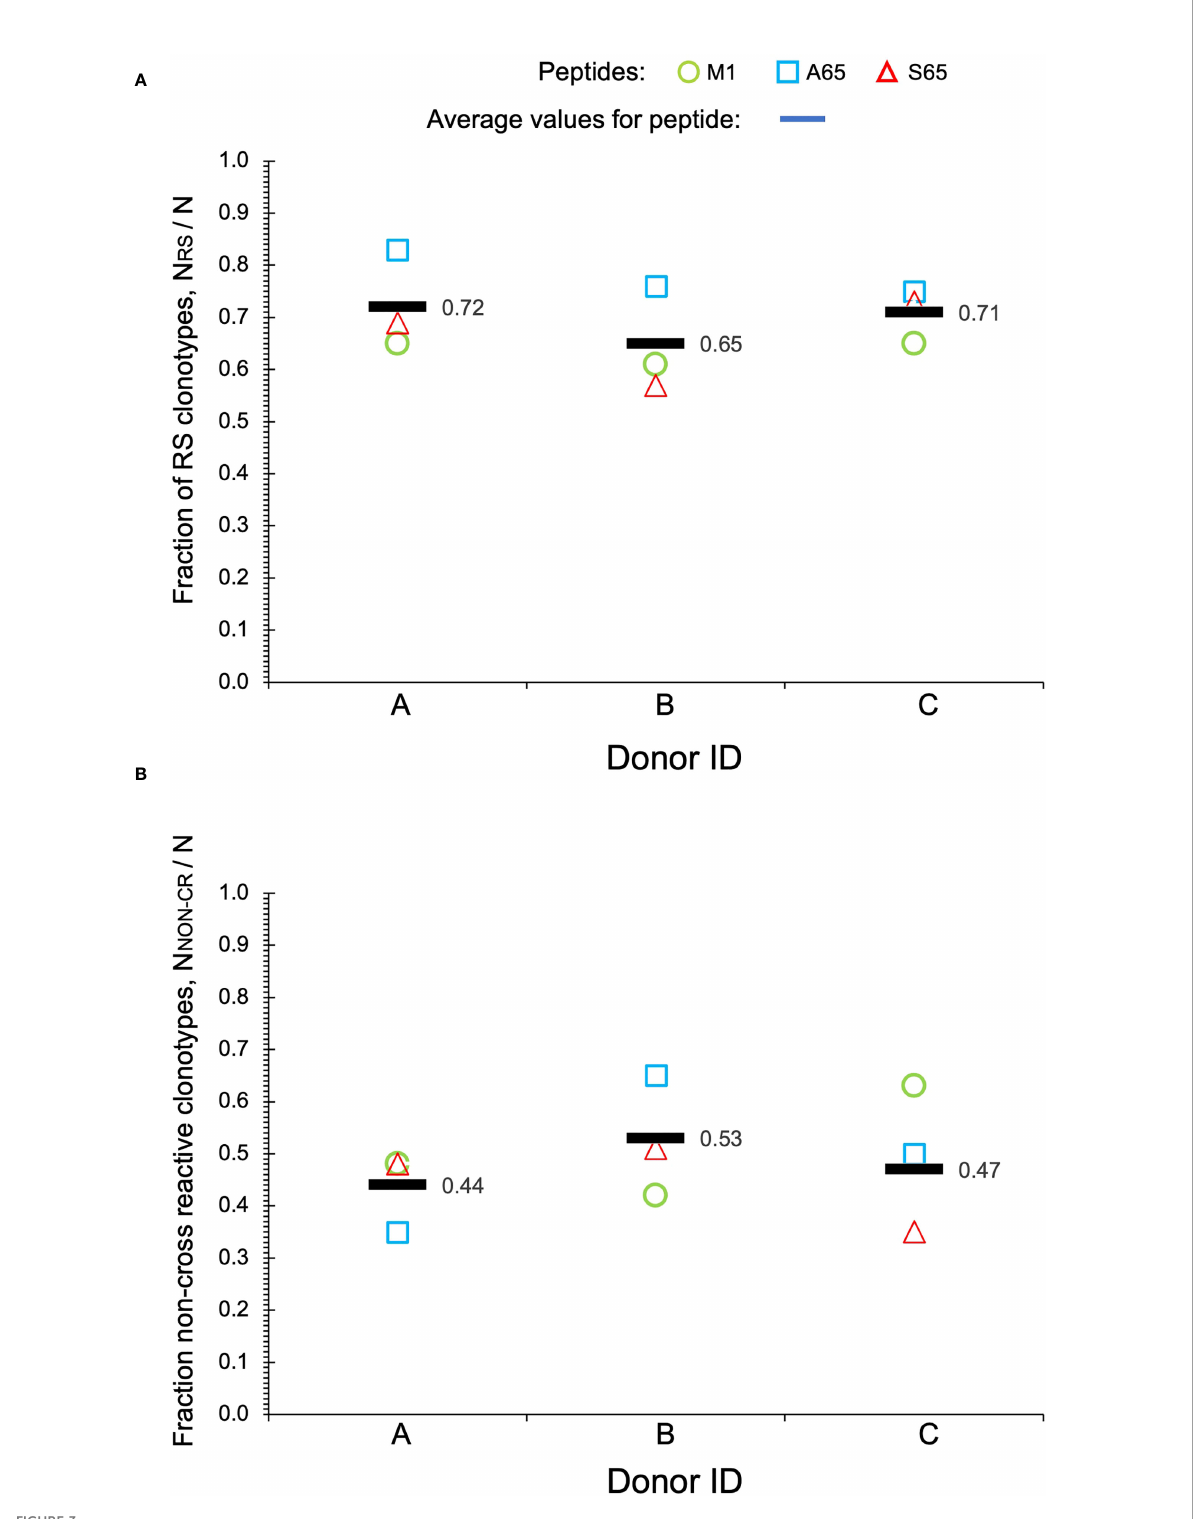
FIGURE 3 Repertoire characteristics. (A) Fraction of RS clonotypes calculated as N RS /N in the BV19 repertoires responding to the two query peptides and M1 in the three donors. Averages are shown by bars. (B) Fraction of clonotypes in the non-cross-reactive component to the repertoires. Data is available in Table